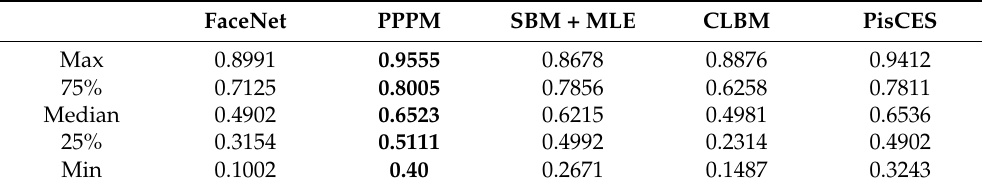
Table 3. The results of the proposed PPPM method and representative model on the Mean ARI (real data).